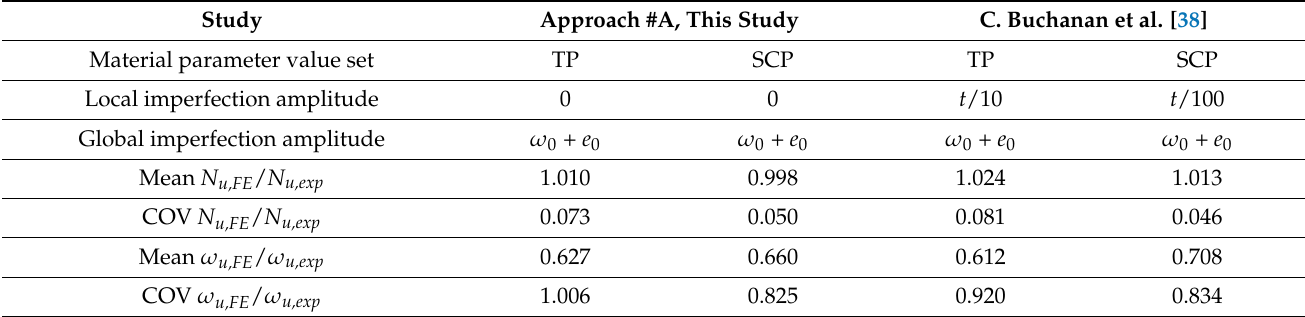
Table 16. Approach #A; Summary of the average N u,FE / N u,exp and ω u,FE / ω u,exp values for varying material properties. Study Approach #A, This Study C. Buchanan et al.